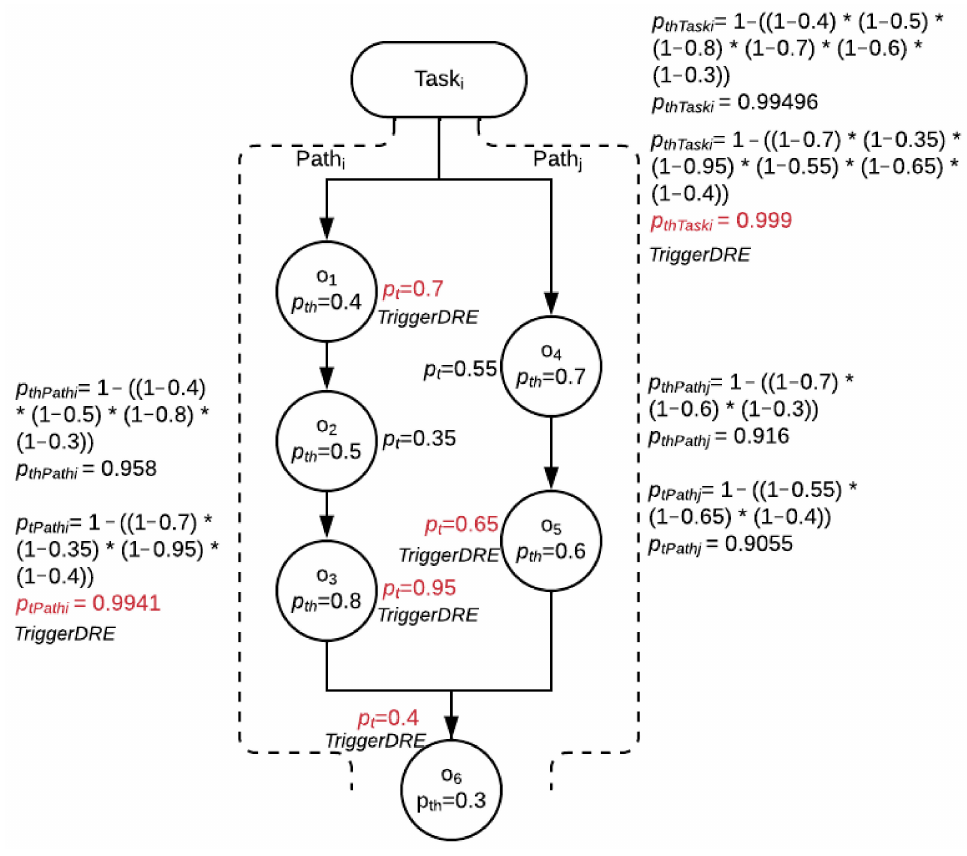
Figure 4. Annotated example illustration of dynamic risk evaluation filter